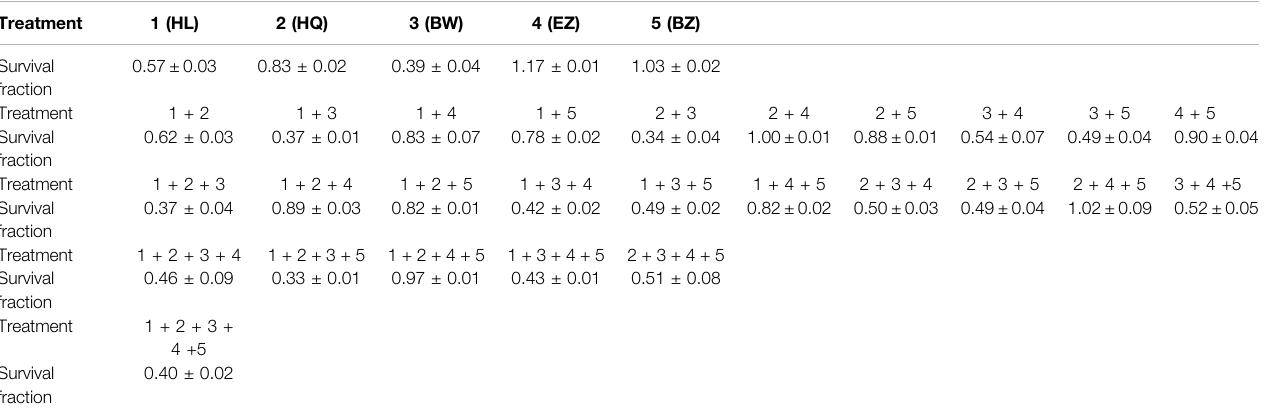
TABLE1| T47Dcellswereseededatadensityof2000cells/wellin96-wellplates.Thecellsweretreatedwithasingledrugsasindicatedorvariouscombinationsofdrugsat 40 μ g/ml for 4 days. The number of survival fractions is shown as the fold change relative to levels observed in the untreated control. The results are presented as the mean ± SD. 1) HL, 2) HQ, 3) BW, 4) EZ, 5)